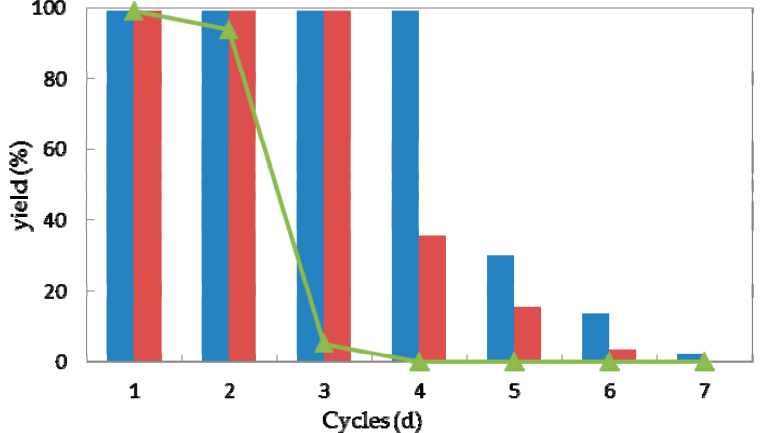
Figure 6. Repeated bioreduction of 1-(2-bromophenyl)ethanone ( 1a ) catalyzed by free (triangles), agar-immobilized (blue striped bar) and calcium alginate-immobilized (red striped bar) cells of G. candidum 2.361 cells.